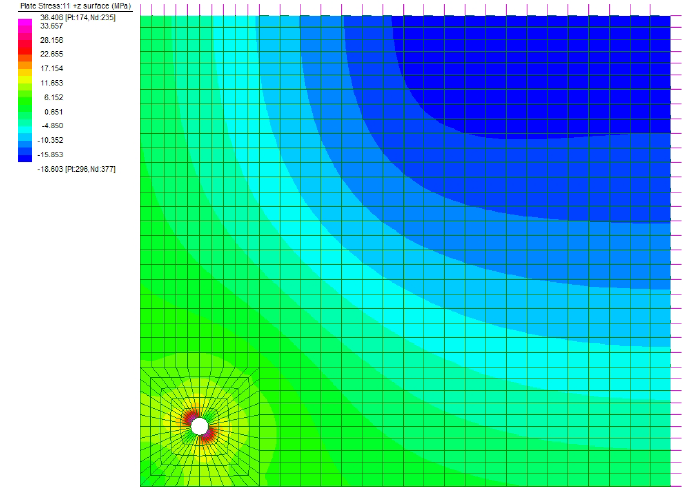
Figure 8: Principal max stress on glass pane (upper side) - σ max =36 MPa < f d =50 MPa.